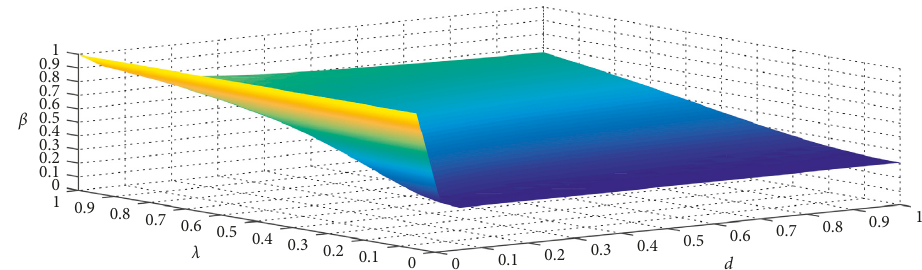
Figure 5: Incentive coefficient for developer β .